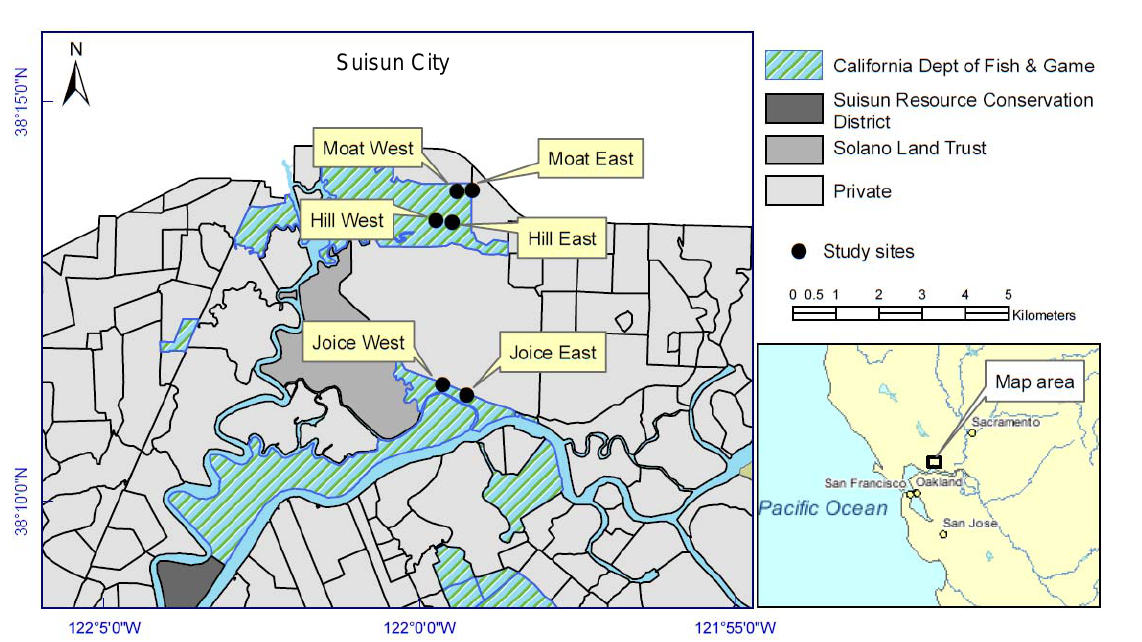
Figure 1. Location of study sites in Suisun Marsh, within the San Francisco Bay Estuary,